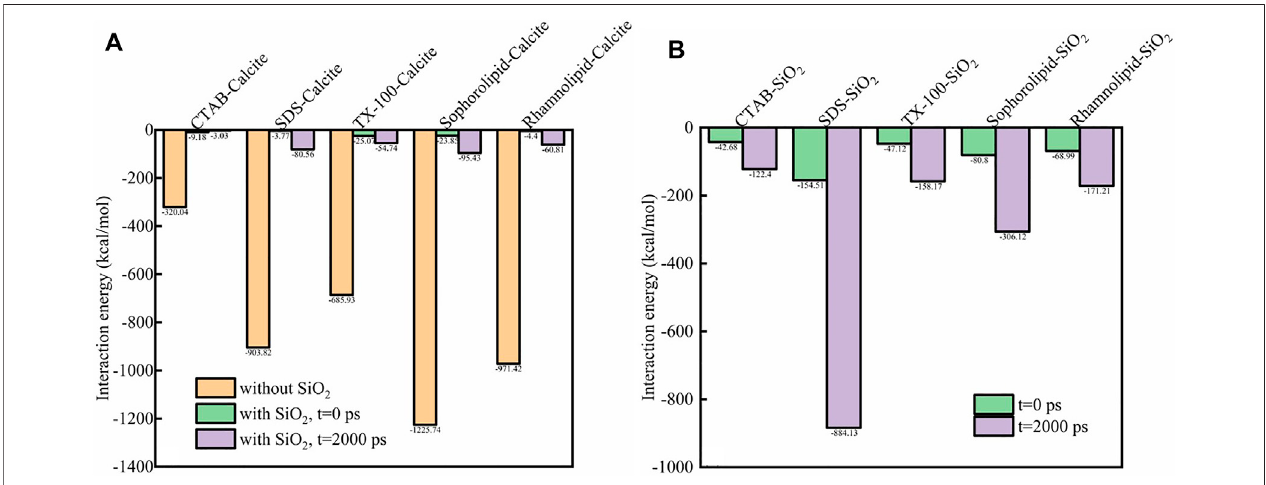
FIGURE 12 | The interaction energy (kcal/mol) between (A) surfactant-calcite surface (with or without SiO 2 nanoparticles); (B) surfactants-SiO 2 nanoparticles.